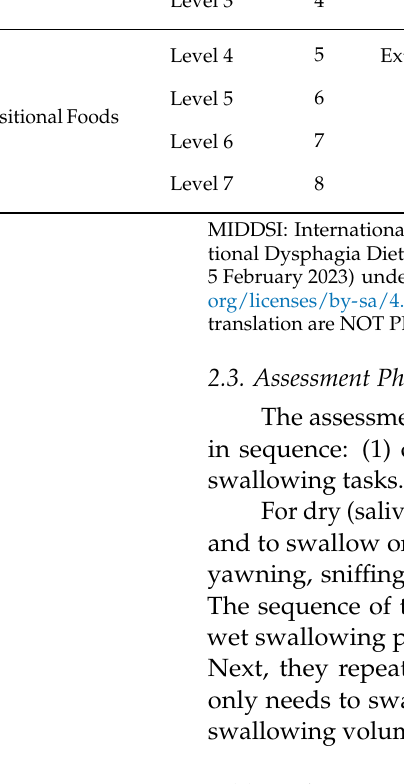
Table 2. The six maneuvers for the non-swallowing